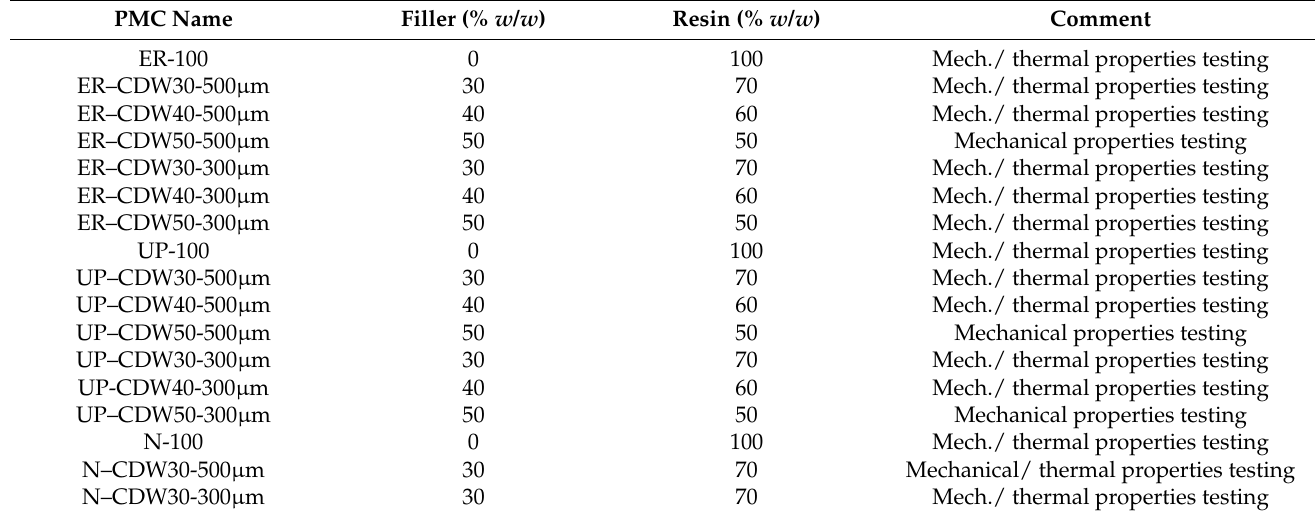
Table 2. Composites manufactured for mechanical and thermal